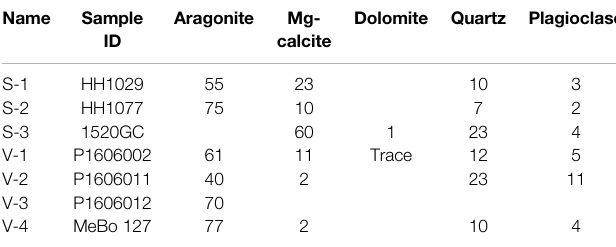
TABLE 2 | Mineralogical compositions (weight-%) of the